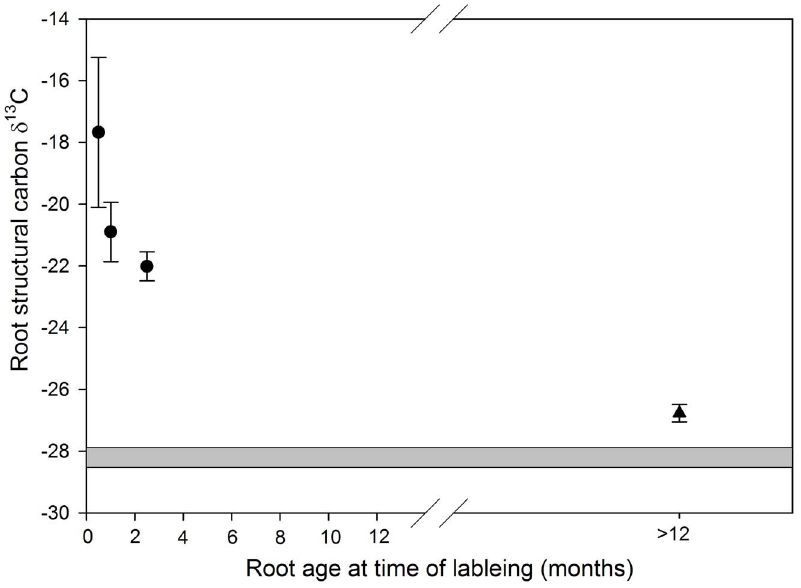
Figure 6. Mean Sassafrasalbidum root structural carbon d 13 C values verses root age at time of sampling. Circles represent roots sampled in 2009. The triangle represents the mean of the late wood (lw) structural root tissue from the 2008 dissection samples which were older than one year when sampled but the exact age is unknown. The grey horizontal bar shows the 95 percentiles for background d 13 C structural carbon values from 2008 and 2009. Note that less negative values indicate greater isotopic enrichment. Error bars denote standard